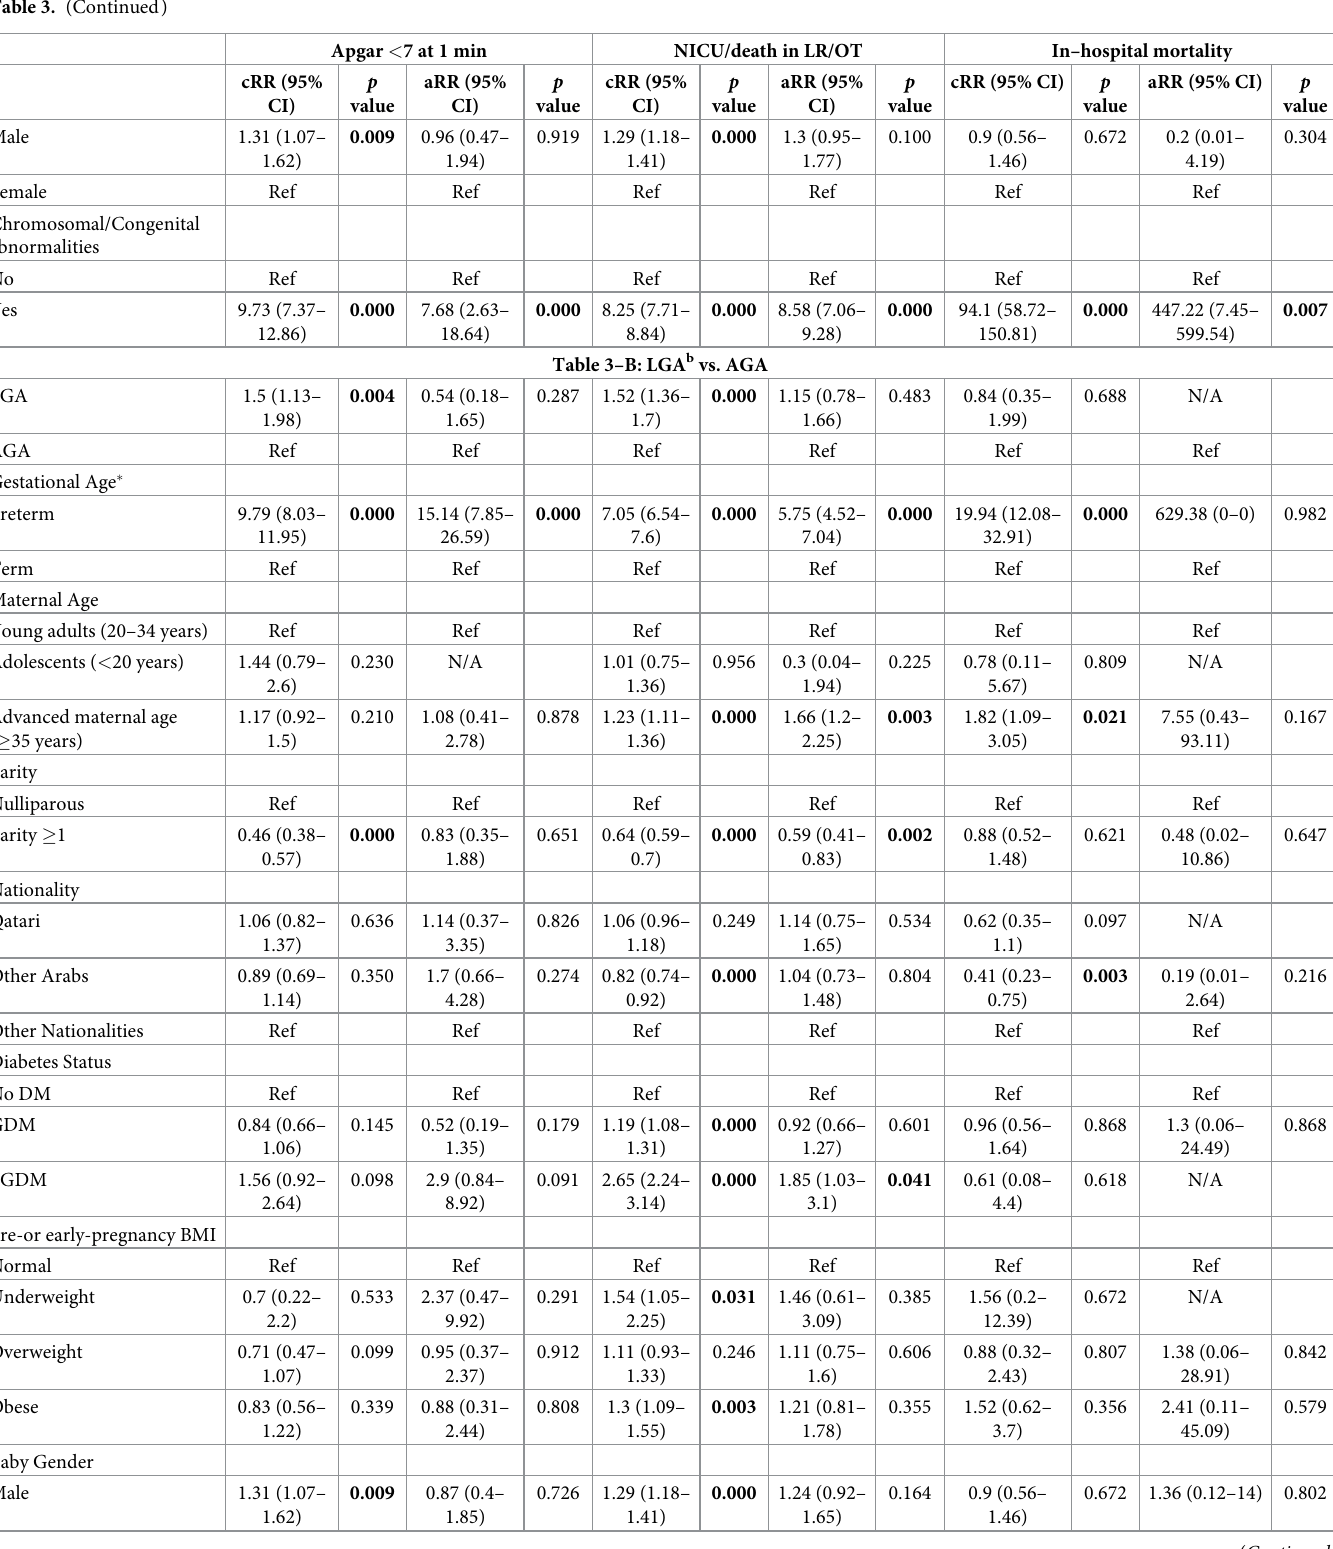
Table 3–B: LGA b vs.